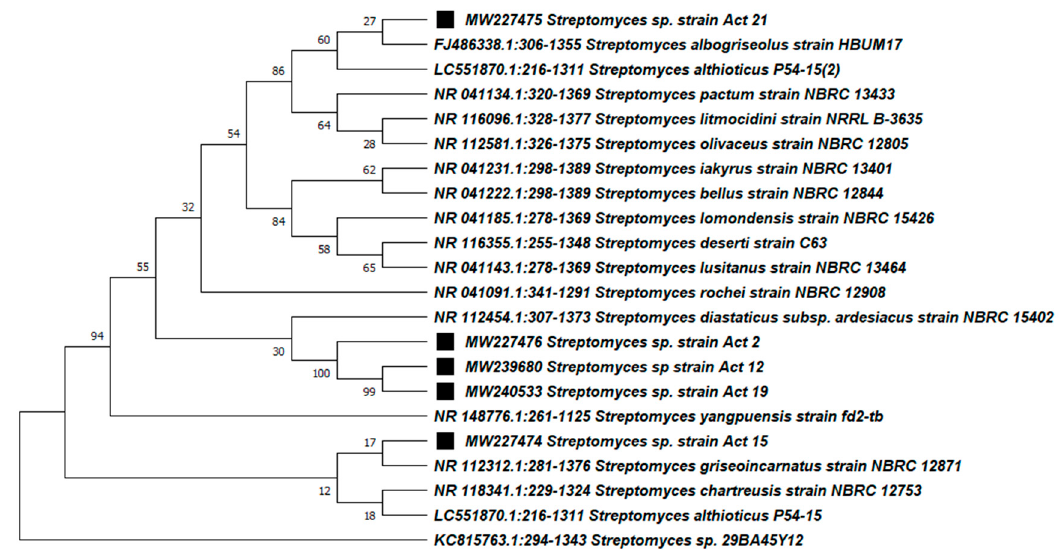
Figure 3. The evolutionary analysis of the five most biologically active actinobacterial isolates as analyzed by phylogenetic tree constructed by the maximum likelihood method using MEGAX software for the 16S rRNA sequences of Streptomyces spp. Act 2, Act 12, Act 15, Act 19 and Act 21. The numbers at nodes represent the percentage values given by 1000 bootstrap samples analysis .